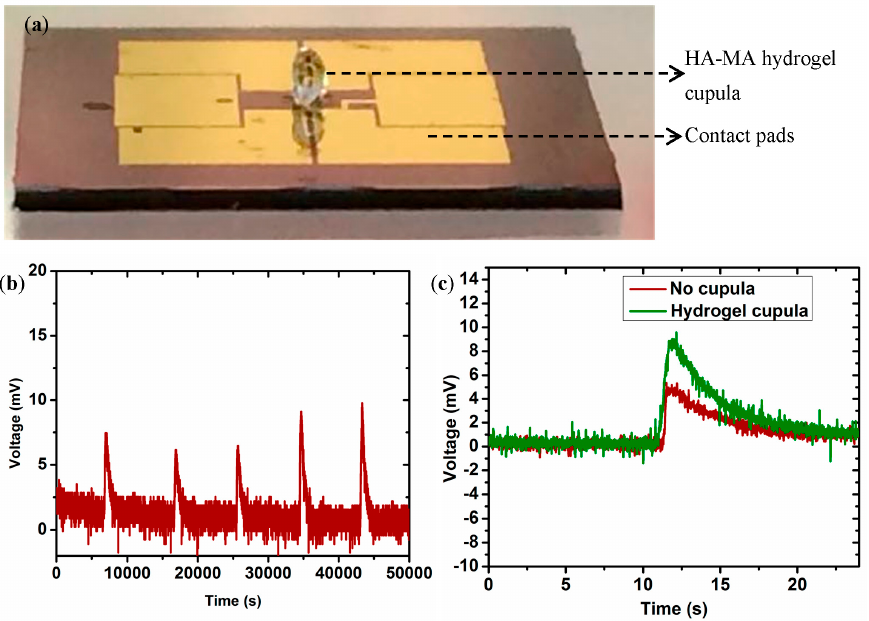
Figure 8. Experimental flow sensing results: ( a ) MEMS sensor with biomimetic hydrogel capping on the hair cell; ( b ) Response of the naked hair cell sensor to five pulses of air flow of velocity 0.2 m/s; ( c ) Comparison of the output of the hydrogel-capped sensor with respect to that of the naked hair cell sensor in response to a flow velocity of 0.1 m/s.